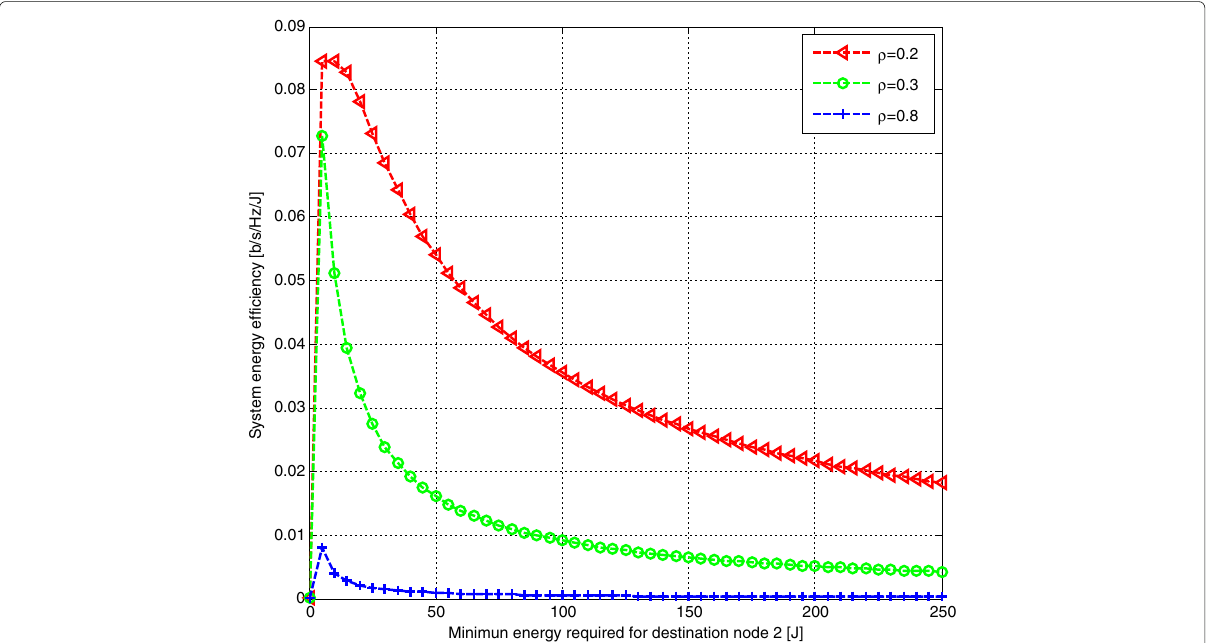
Fig. 5 Achieved energy efficiency of the whole IoT systems by the proposed scheme at the different power splitting factor ρ with a = 5, b = 10